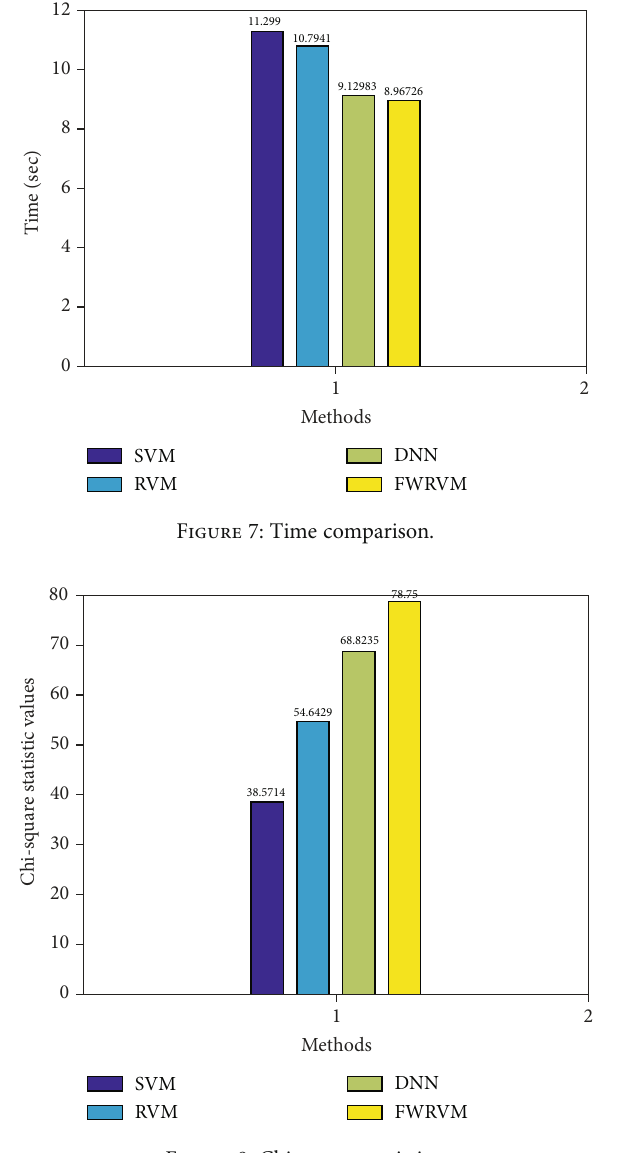
Figure 8: Chi-square